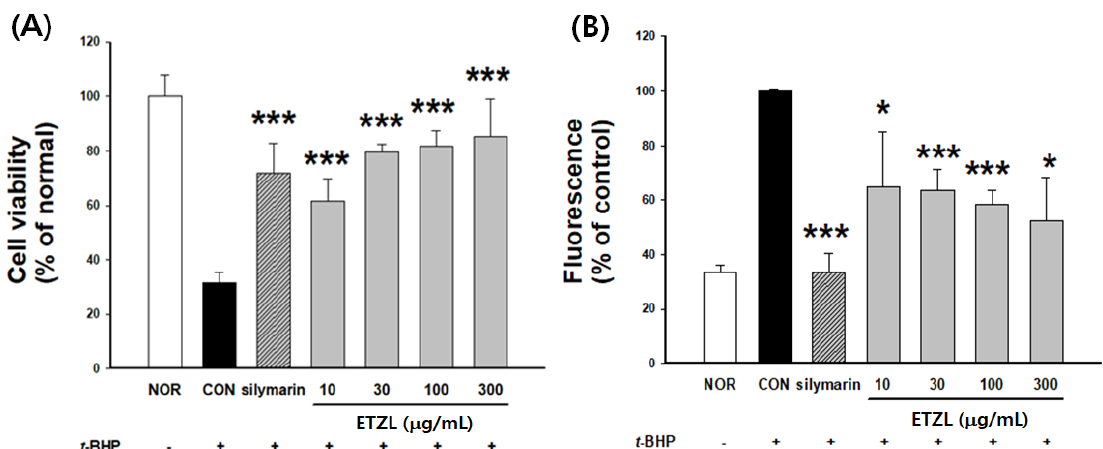
Figure 5. Effects of ETZL on ( A ) cytotoxicity and ( B ) inhibition of reactive oxygen species (ROS) generation in tert -butyl hydroperoxide ( t -BHP)-treated cells. Cells were treated with ETZL and subsequently incubated for 12 h with t -BHP (50 µ M). The group treated with t -BHP was marked with a (+) mark on the X-axis. Cell viability and ROS generation were determined as described in the Materials and Methods section. Silymarin was used as a positive control. Values are expressed as mean ± SD ( n = 3). Significant differences compared with the t -BHP-treated group(CON;control) are indicated by * p < 0.05, *** p < 0.001.